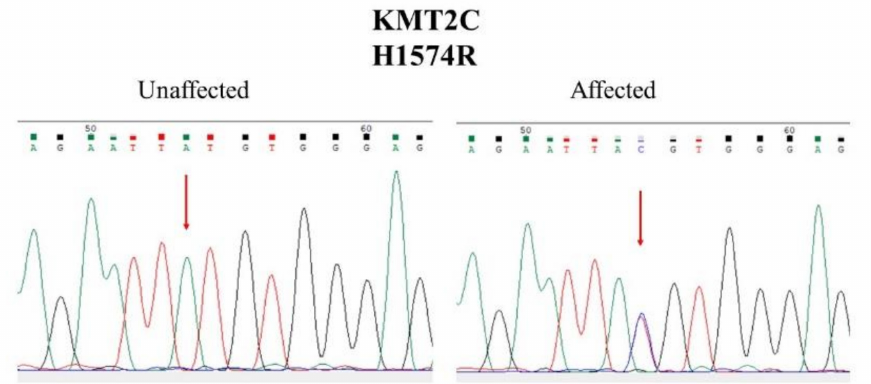
Figure 3. Representative results of Sanger sequencing of the H1574R mutation of KMT2C in affected members and the wild-type mutation of KMT2C in the unaffected